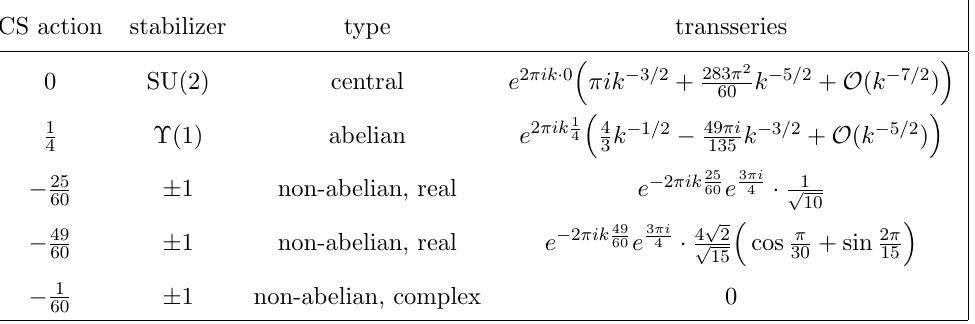
Table 8 . Transseries and classi(cid:12)cation of (cid:13)at connections on M ( the center